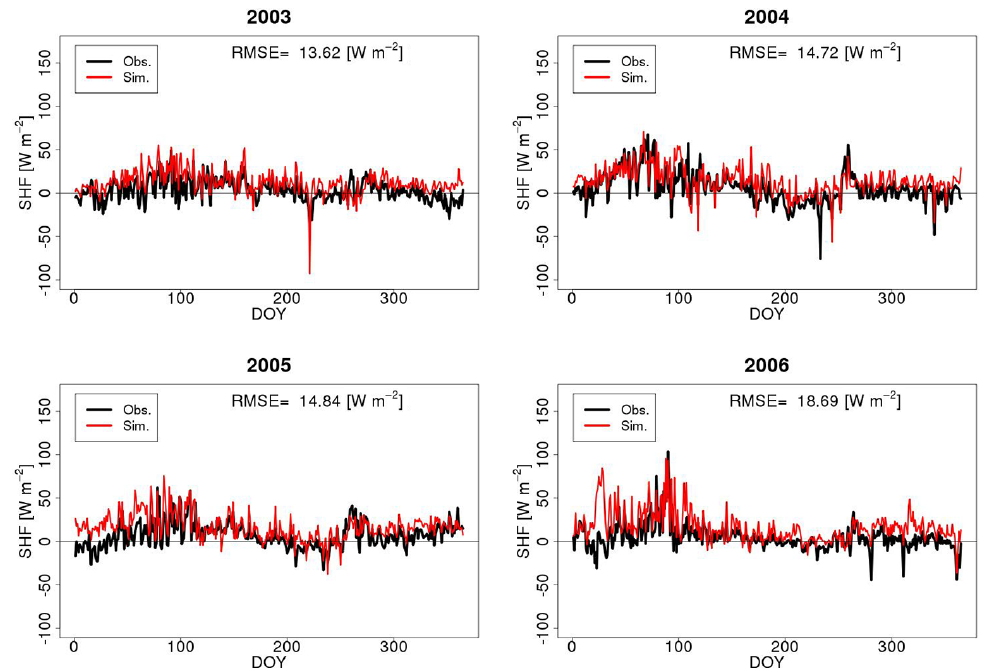
Figure 9. Comparison of SHF between simulations and observations. DOY indicates the number of days from 1 January.